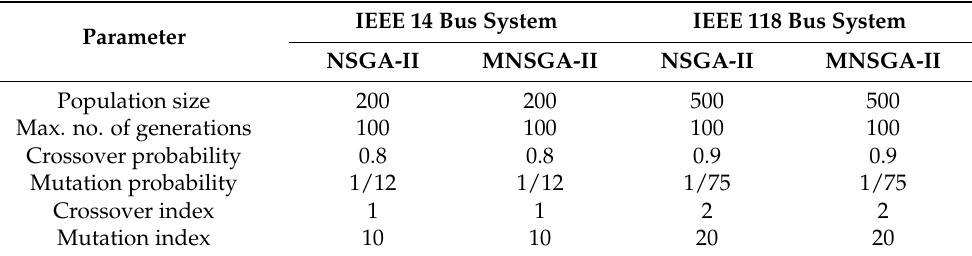
Table 2. Parameter selection for NSGA-II and